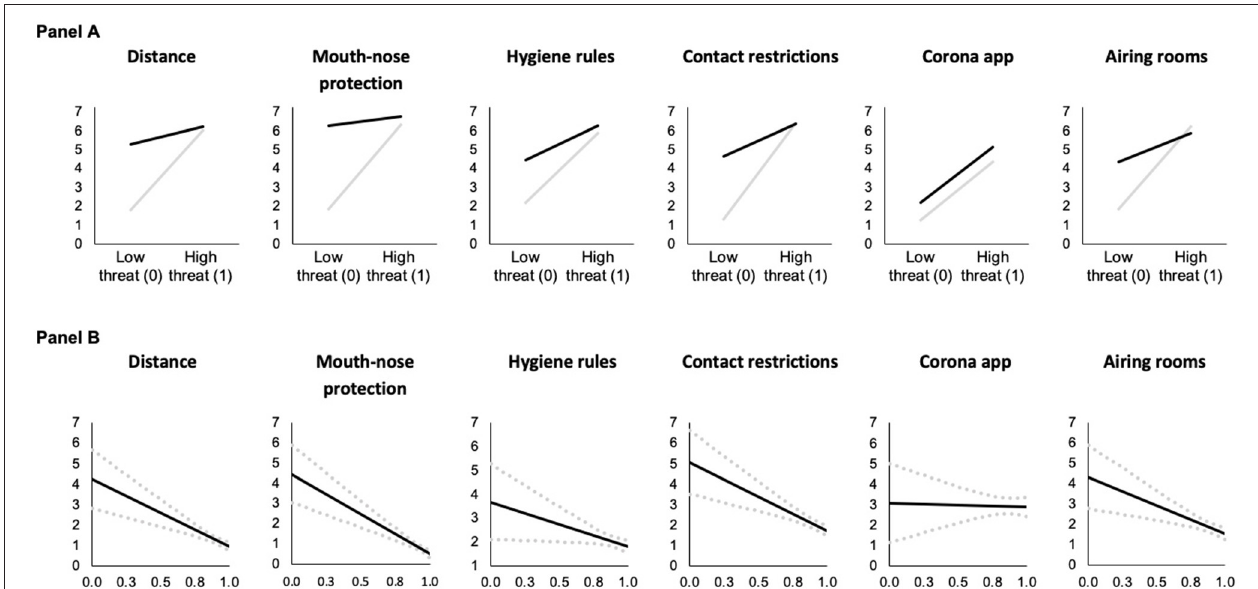
FIGURE 6 | Predicted adherence as a function of COVID-19 threat at different levels of knowledge about COVID-19 (A) and conditional effect of COVID-19 threat as a function of knowledge about COVID-19 (B) in risk of severe infection models (based on Models 9 and 14 in Tables 6 , 7 , N = 4,096). In (A) , gray lines ( — ) indicate low knowledge (0) and black lines ( — ) indicate high knowledge (1). Predictions are for men who are 18 years old and at risk of severe COVID-19 infection. In (B) , the black solid lines ( — ) indicate the conditional effect of perceived COVID-19 threat from the lowest (0) to the highest (1) level of knowledge about COVID-19 and dotted gray lines ( • • • ) indicate the upper and lower 95% confidence interval; and all Johnson-Neyman values are statistically significant ( p <